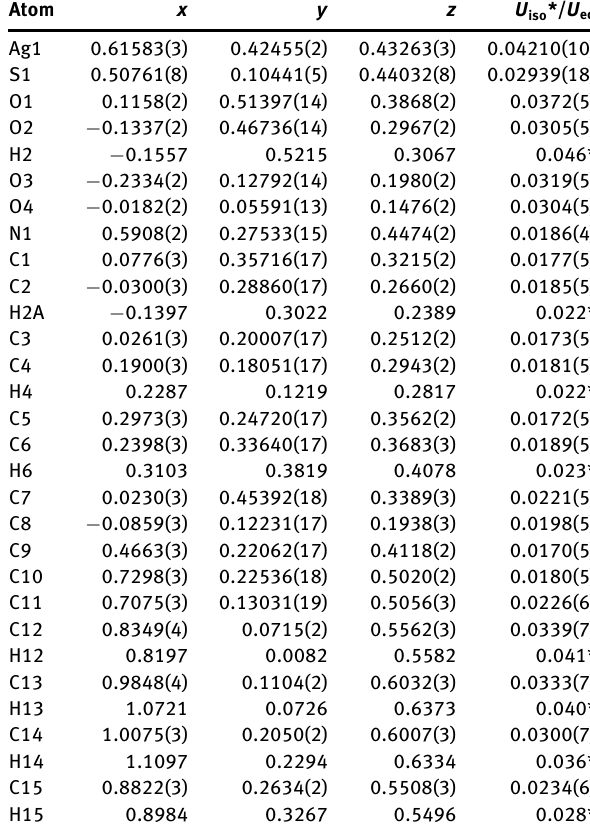
Table 2: Fractional atomic coordinates and isotropic or equivalent isotropic displacement parameters (Å 2